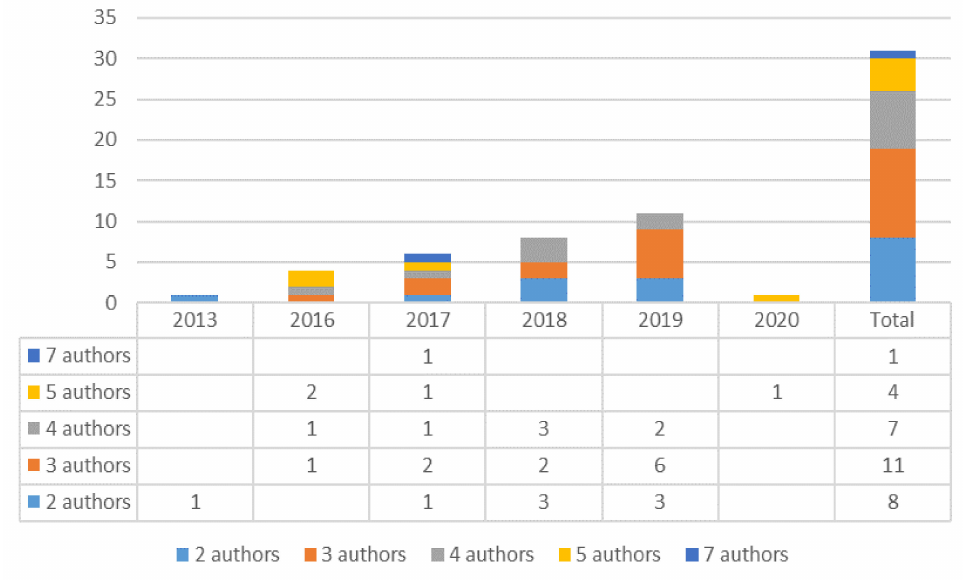
Figure 10. Most collaborative authors (source: